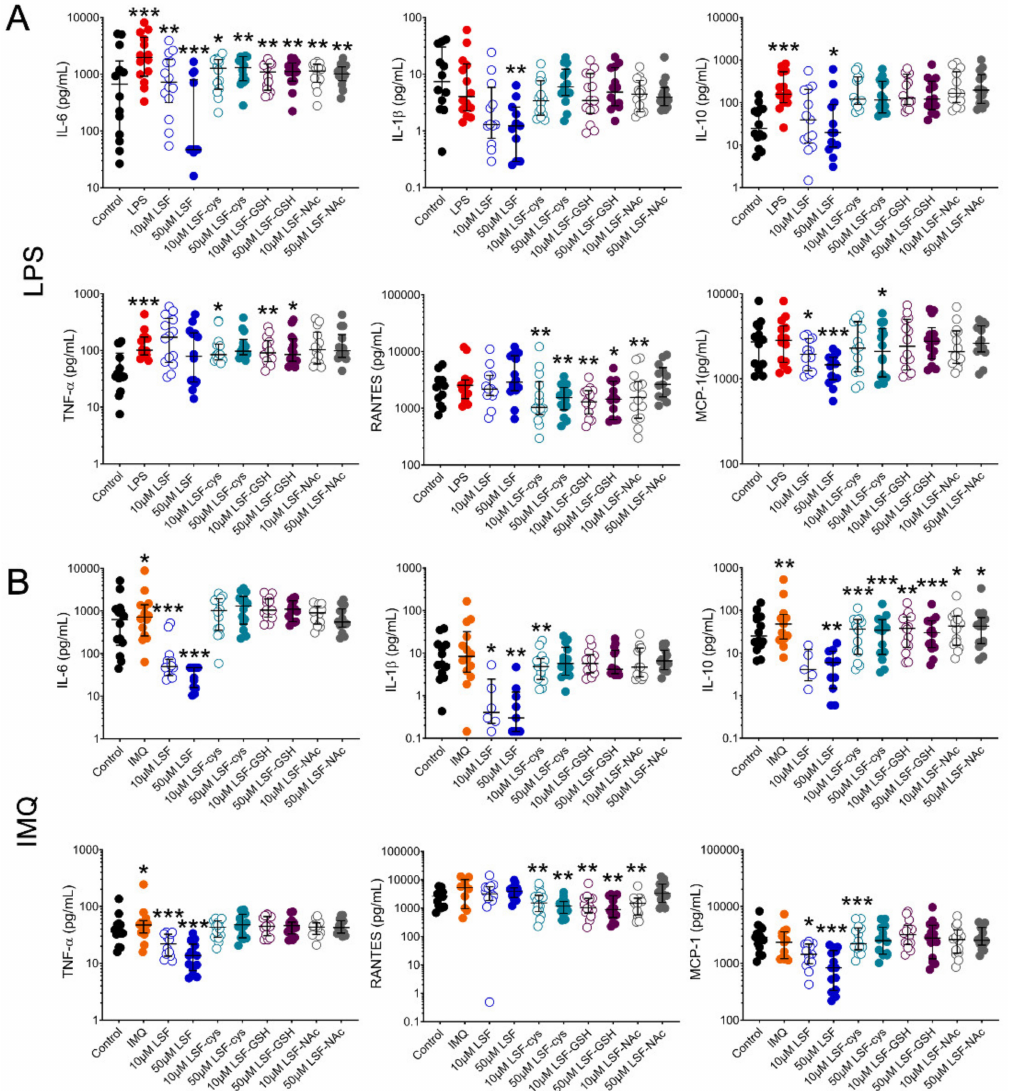
Figure 1. LSF effect on cytokine and chemokine secretion. Cytokine and chemokine measurements in supernatants from healthy adult PBMCs ( n = 14) following pre-treatment with 10 µ M or 50 µ M LSF or its metabolites (LSF-cys, LSF-GSH, LSF-NAc) for 24 h before stimulation with LPS (10 ng/mL) ( A ) or IMQ (5 mg/mL) ( B ) for a further 24 h. The medium control was used as the control group for comparisons with the TLR-stimulated groups; the DMSO control was used as the vehicle control for comparison with the LSF treatments. * p < 0.05, ** p < 0.01, *** p < 0.001 compared to the respective stimulation controls, assessed by a non-parametric Wilcoxon signed-rank test. The median ± IQR range is displayed. Legend: • Control, • LPS, • IMQ, • LSF, • LSF-cys, • LSF-GSH, • LSF-NAc (10 µ M are open circles and 50 µ M are closed circles).Abbreviation: IL, interleukin; IMQ, imiquimod; IQR, inter-quartile range; LPS, lipopolysaccharide; LSF, L-sulforaphane; LSF-cys, LSF-cysteine; LSF-GSH, LSF-glutathione; LSF-NAc, LSF-N-Acetyl-L-cysteine; MCP-1, monocyte chemoattractant protein -1; PBMC, peripheral blood mononuclear cells; RANTES, Regulated upon Activation, Normal T Cell Expressed and Presumably Secreted; TNF- α , tumour necrosis